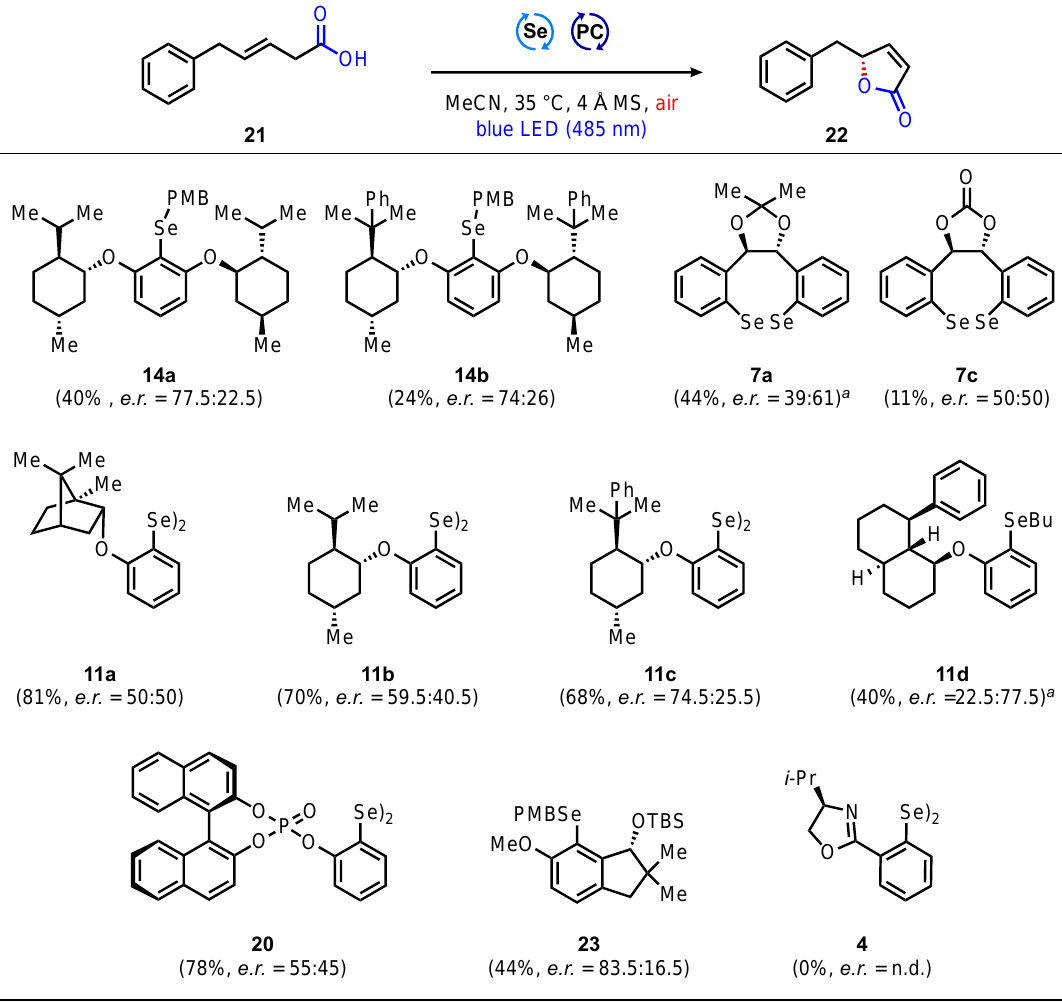
Table 3. Screening of selenium- π -acid catalysts in the enantioselective aerobic lactonization of 5-phenylpent-3-enoic acid ( 21 ).